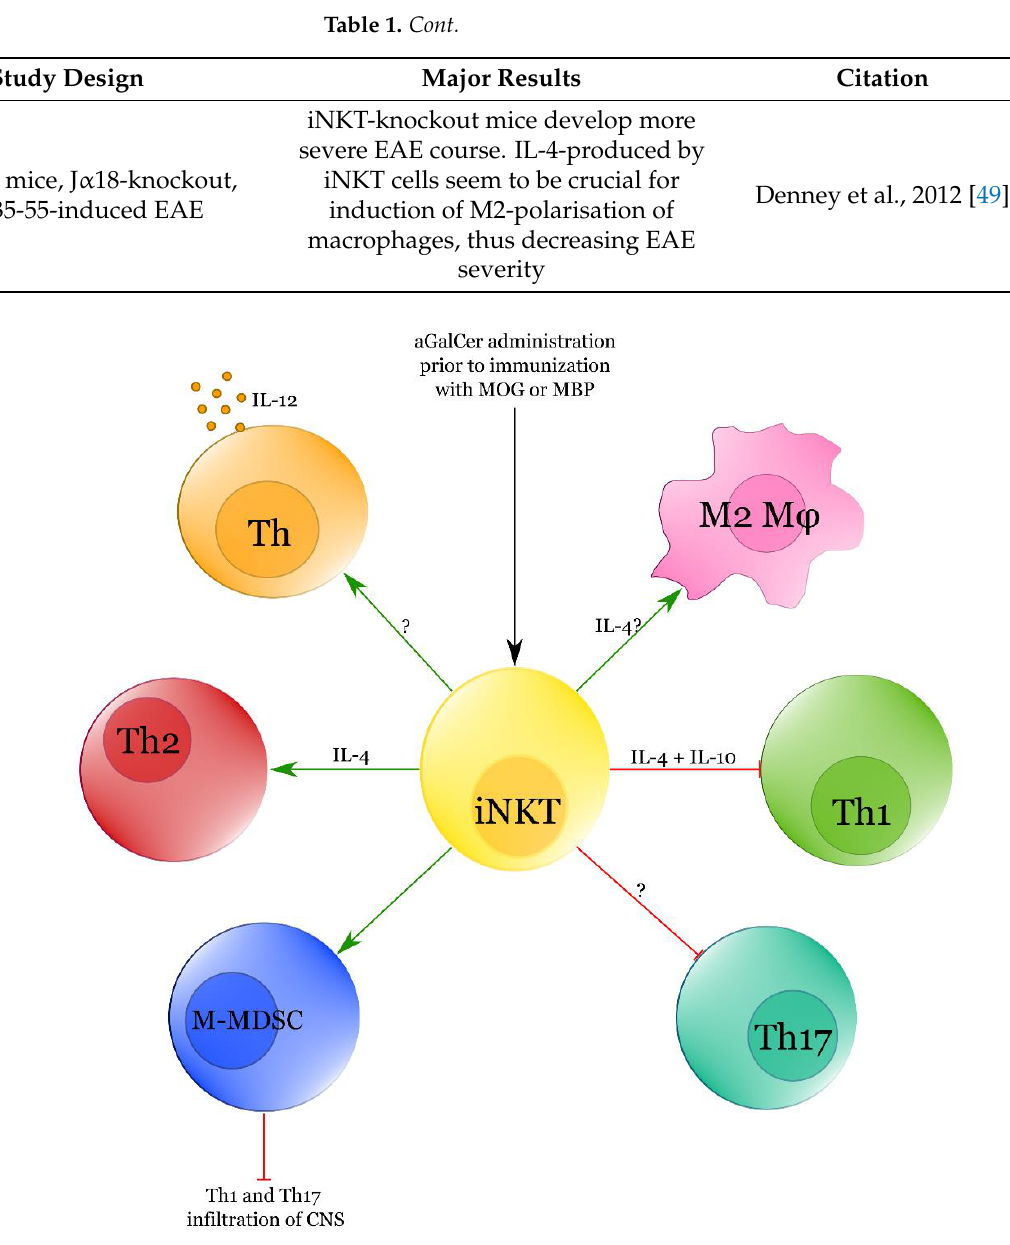
Figure 2. Major modes of action of iNKT cells in EAE. Red lines are for inhibitory while green ones for promoting interactions. M-MDSC — monocytic myeloid-derived suppressor cells. Th — T helper cells, M2 Mφ— M2 macrophages. Table 1. Involvement of iNKT in EAE — major studies.